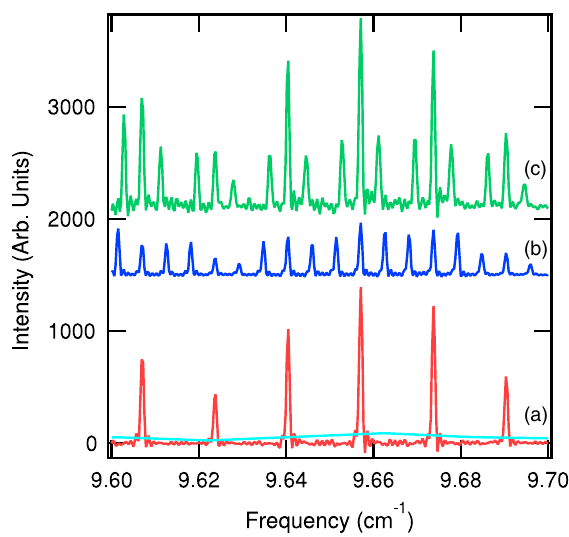
FIG. 4. The frequency spectra in detail showing the super- radiant peaks for the various bunch-train fill patterns. (a) Fill pattern 11111 . . . (low-resolution spectrum overlaid); (b) fill pattern 100100 . . . ; (c) fill pattern 11001100 . . . [(b) and (c) offset for clarity].